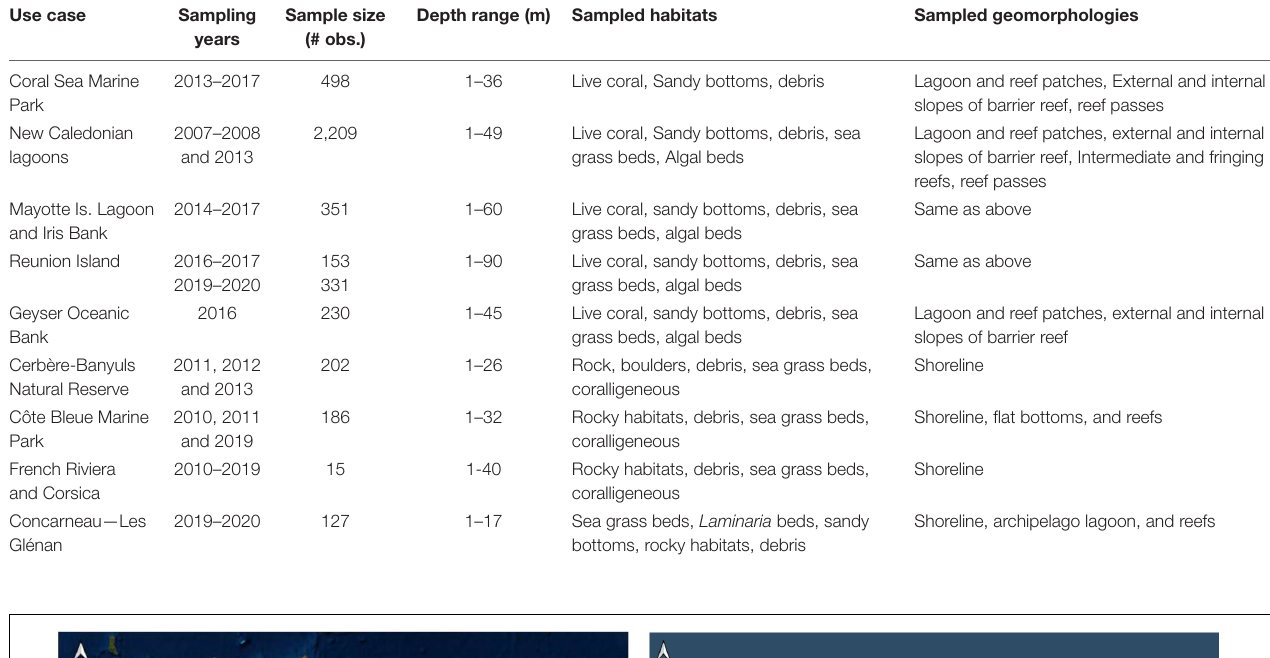
TABLE 6 | Main features of samples for the use cases.